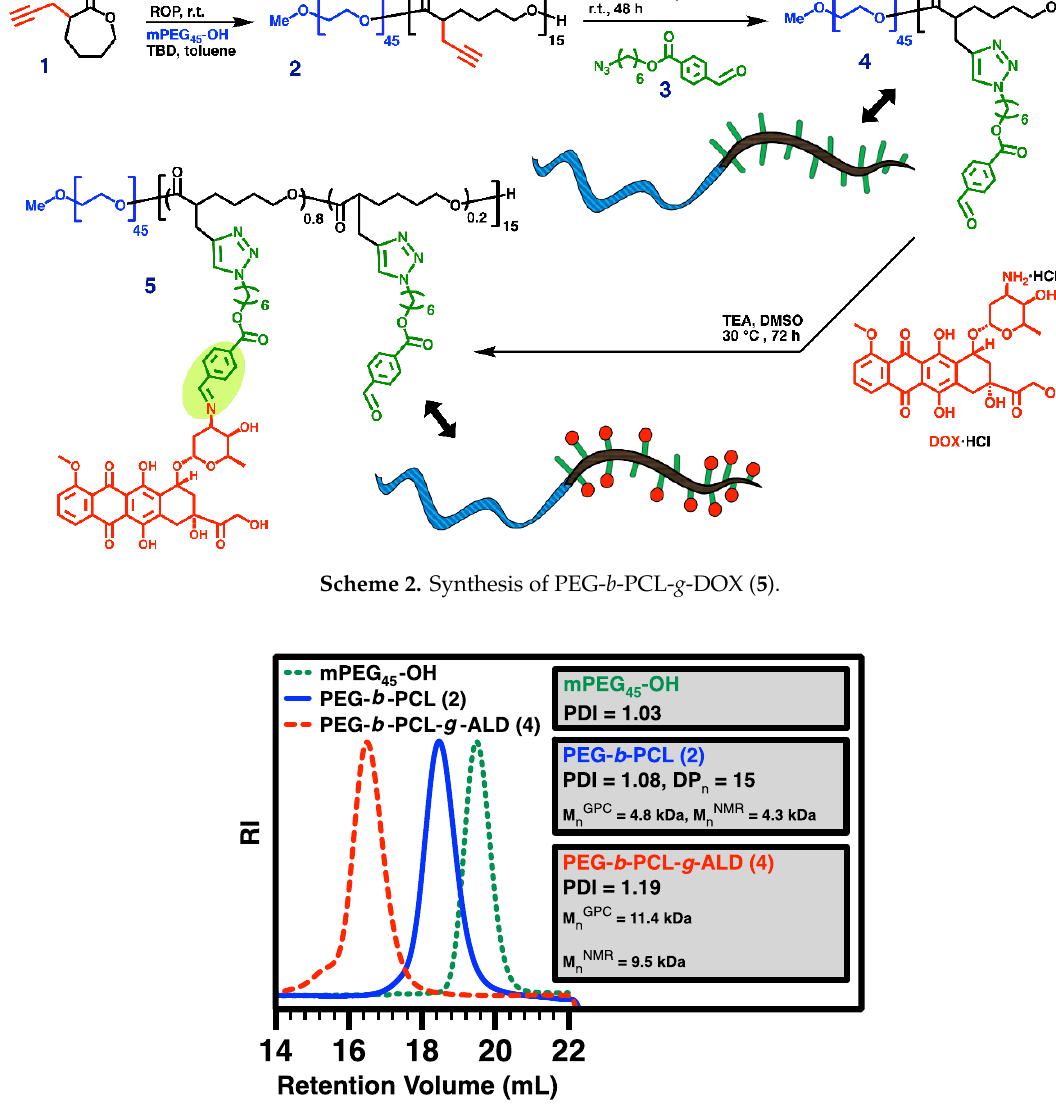
Figure 4. Gel permeation chromatography (GPC) characterization of mPEG 45 -OH as the ring-opening polymerization (ROP) macroinitiator, alkyne-functionalized PEG- b -PCL ( 2 ), and PEG- b -PCL- g -ALD ( 4 ) in DMF as eluent. The inserted panels show additional information about each polymer.